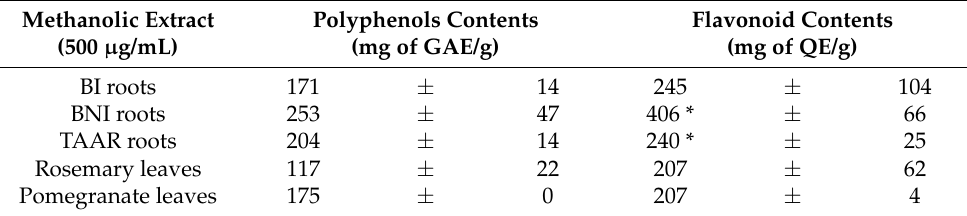
Each value in the table is represented as mean ± SD (n = 3). The data are presented as mean (SD) values for each experimental condition (n = 3), and a nonparametric Mann–Whitney test analysis was used to compare the statistical differences between extracts. * Indicates statistically significant differences as compared to controls ( p < 0.05).